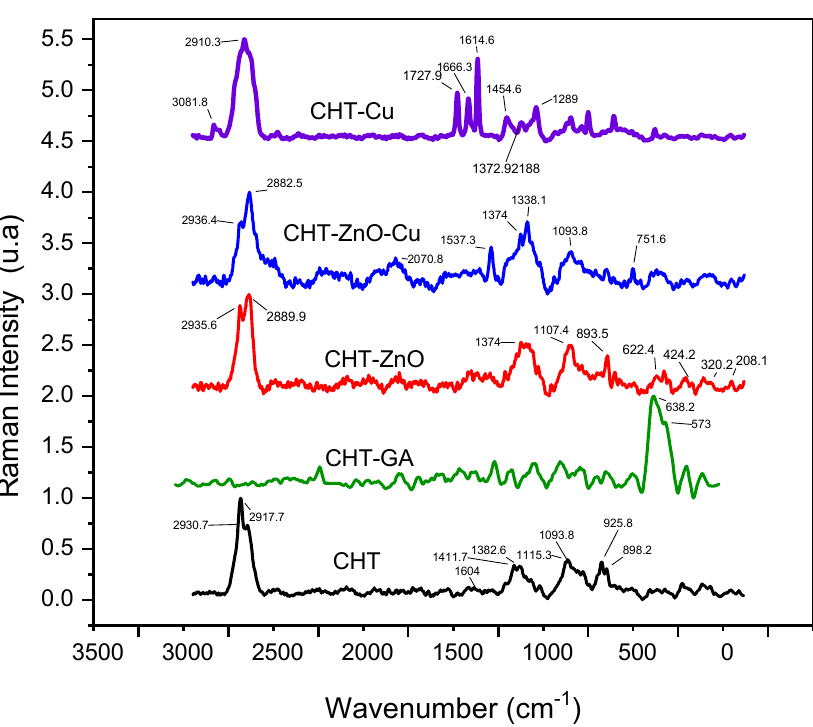
Figure 2. Raman spectra of chitosan crosslinked GA (CHT/GA) chitosan with zinc oxide (CHT/Zn ‐ O), chitosan with copper nanoparticles (CHT/Cu) and chitosan with zinc oxide/copper nanoparticles (CHT/Zn ‐ O/Cu).